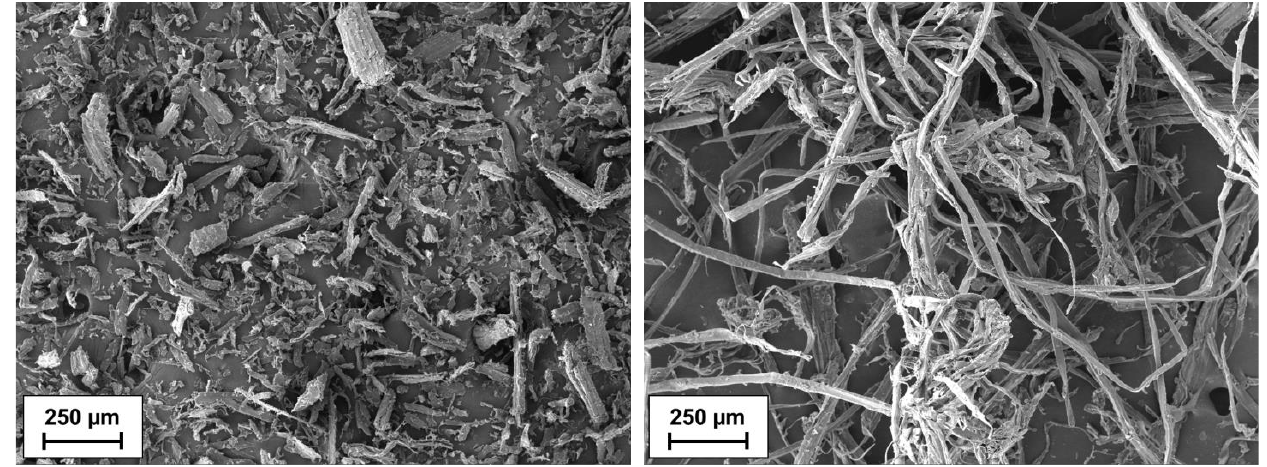
Figure 1. SEM backscatter images of wood flour ( left ) and wood fibers ( right